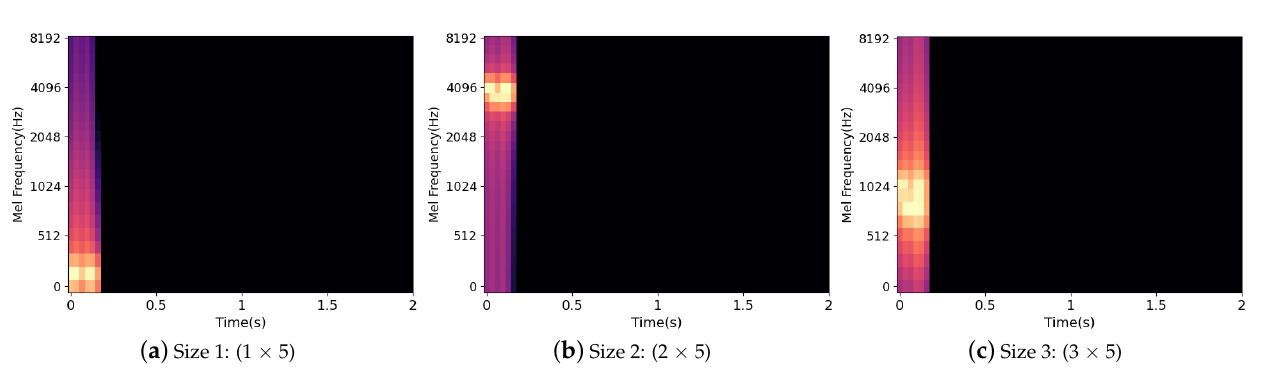
Figure 4. Three kinds of trigger